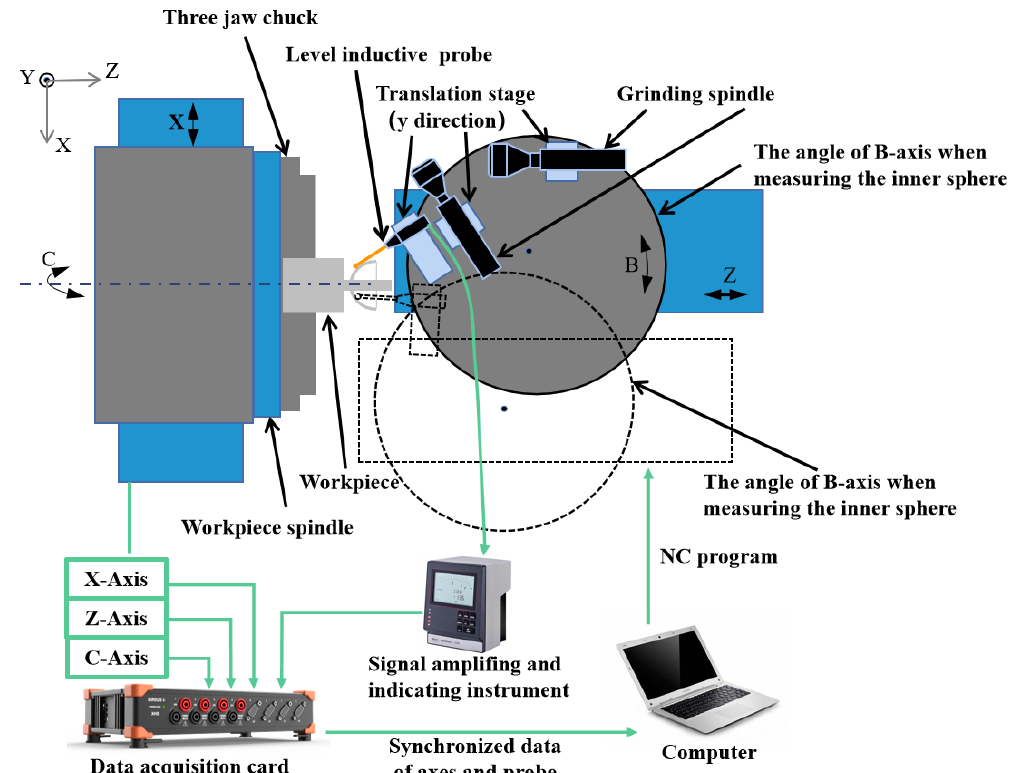
Figure 3. On-machine measurement system for the HSRs and signal flow.